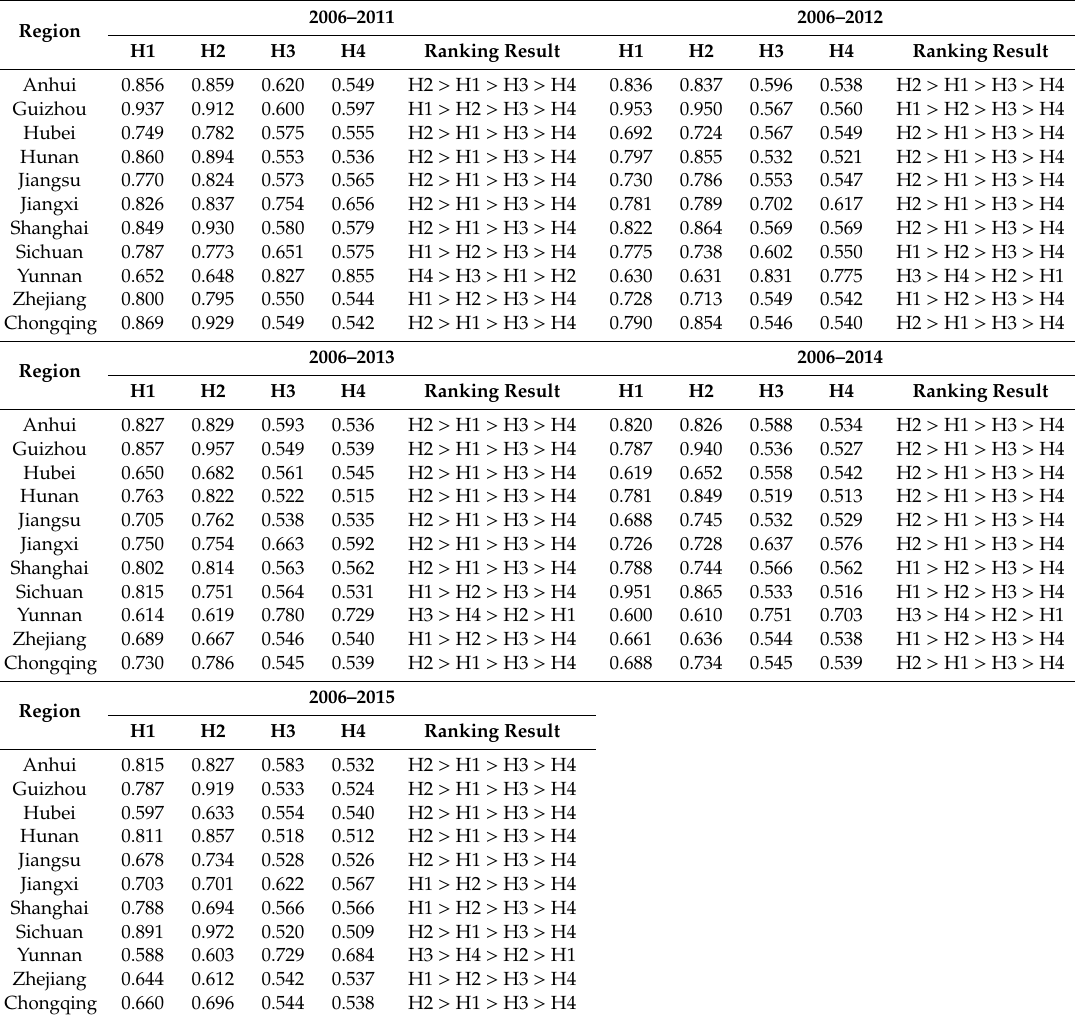
Table 3. Grey comprehensive relevance degree of sustainable development level and spatial structure in the 11 provinces and cities of the Yangtze River Economic Belt at di ff erent